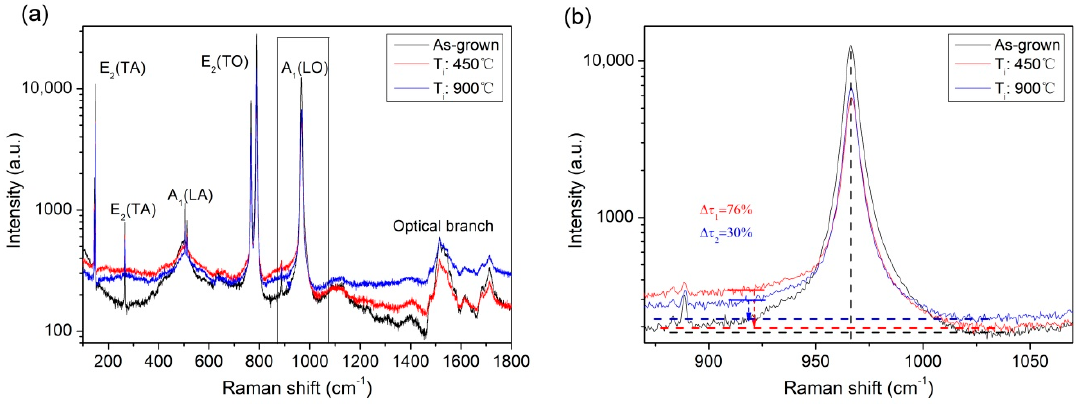
Figure 2. Raman spectra of ( a ) 6H-SiC implanted by H 2+ -ion at 450 °C and 900 °C showing first-order (E 2 (TO) and A 1 (LO)) and second-order (E 2 (TA), E 1 (TA), A 1 (LA) and optical branch) peaks, compared with the as-grown 6H-SiC, ( b ) enlarged A 1 (LO) peak shown in figure ( a ), where the left tail of the peak lifted after ion implantation. The intensity of the asymmetry decreased with increasing implantation temperature.